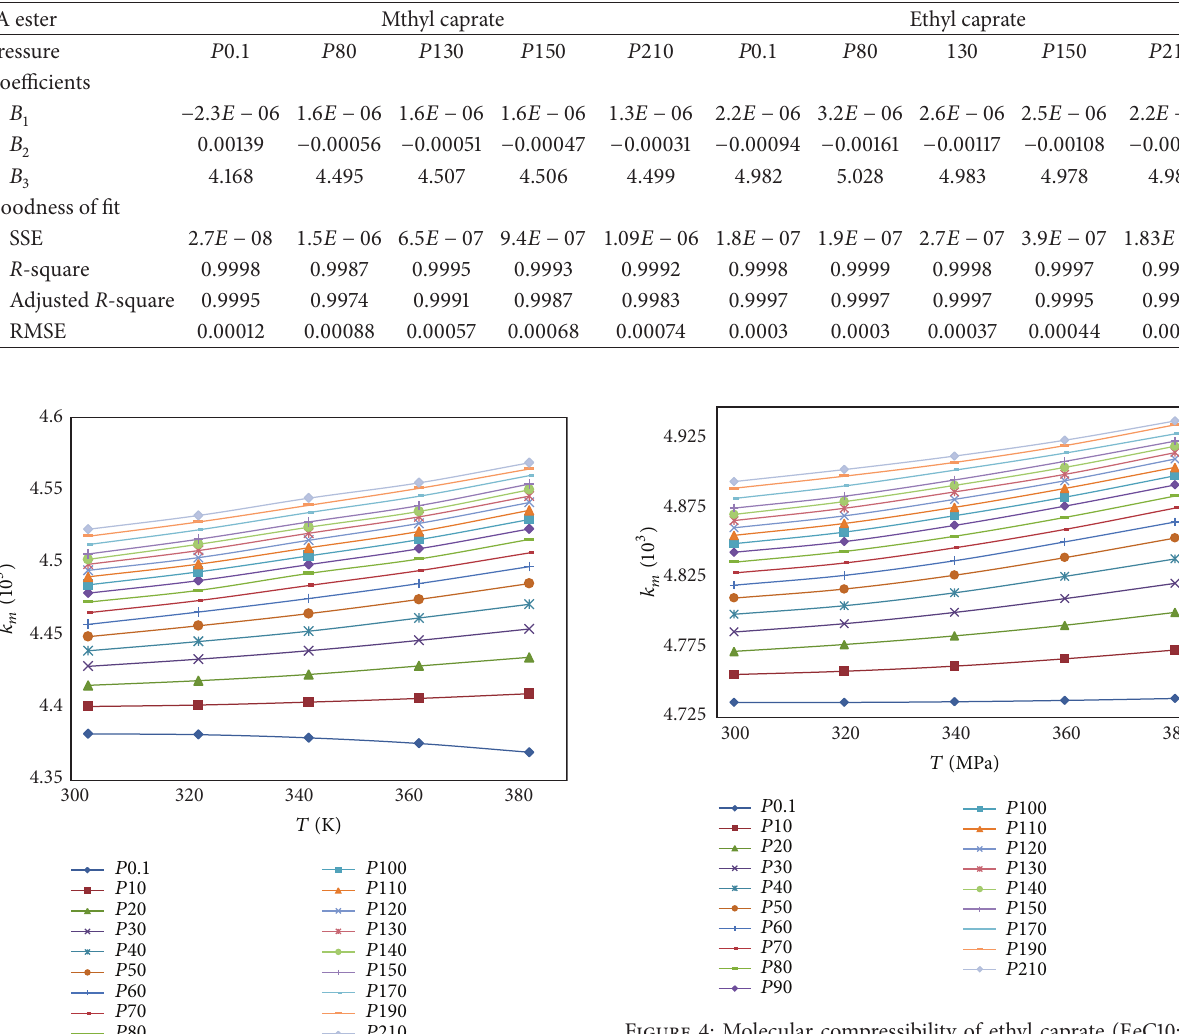
Table 3: Fitting coefficients for (10) along various isobaric.